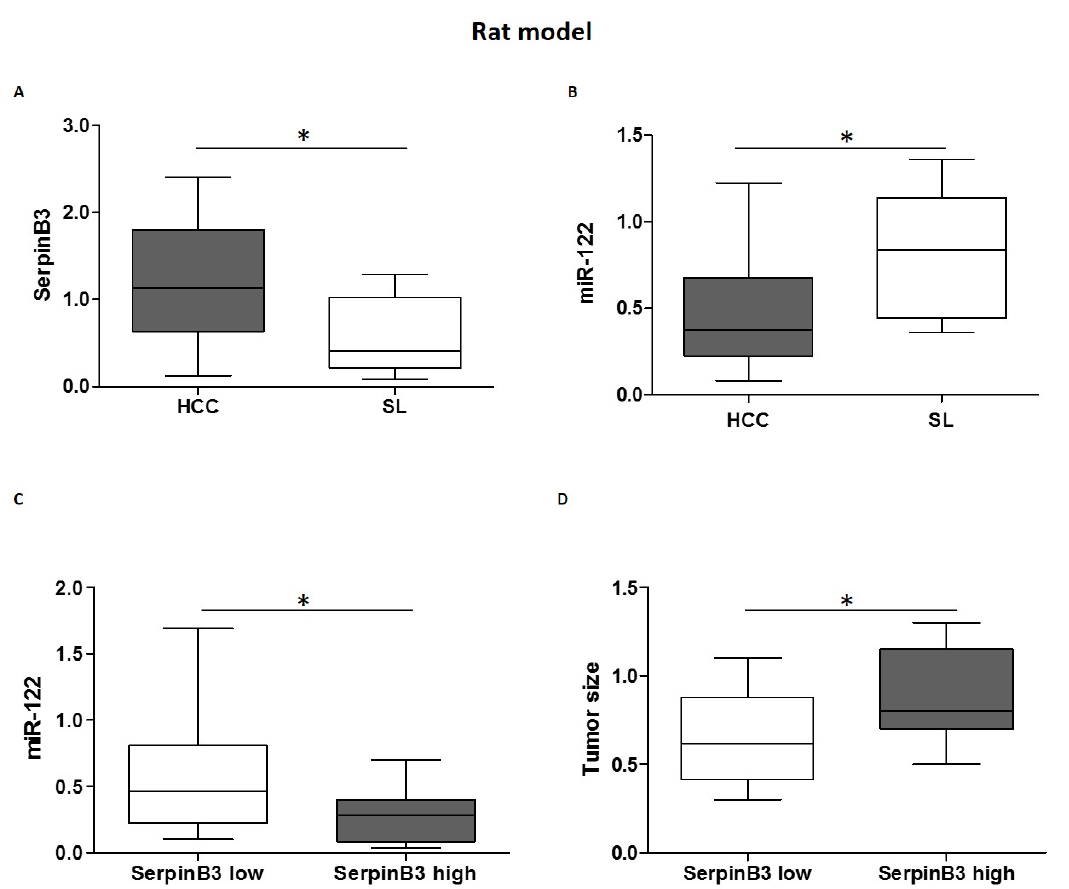
Figure 2. ( A ) SerpinB3 and ( B ) miR-122 expression in hepatocellular carcinoma (HCC) nodules and matched surrounding liver (SL) tissues from diethyl nitrosamine (DEN)-induced HCC rats. Y-axis reports 2 − ∆∆ Ct levels from qPCR analysis. The values are represents as box-and-whiskers graph with the minimum, maximum, and median data. (* p < 0.05 Mann–Whitney test). ( C ) MicroRNA (MiR)-122 expression in tumor tissues from HCC rats in relation to SerpinB3 expression. HCCs were grouped on the basis of SerpinB3 expression as detected by qPCR analysis (* p < 0.05 Mann–Whitney test). Specifically, the high SerpinB3 group included HCC specimens with a cycle threshold (Ct) value lower than 35, whereas the low SerpinB3 group included HCC specimens with a Ct value higher than 35. ( D ) Box plot graph representing tumor size in HCC rats in relation to SerpinB3 expression (* p < 0.05 Mann–Whitney test). Tumor size was represented by the value of major diameter (cm).